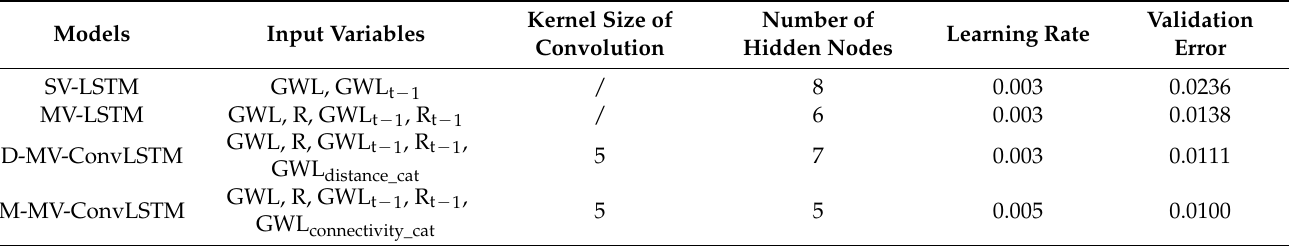
Table 3. Input variables and model parameters that were selected for four